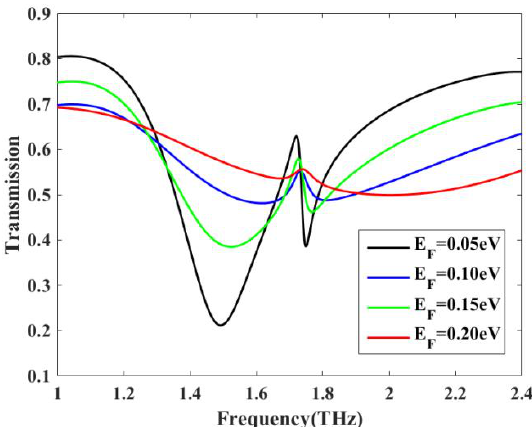
Figure 4. Transmission spectra of the hybrid metamaterial with different Fermi energy.